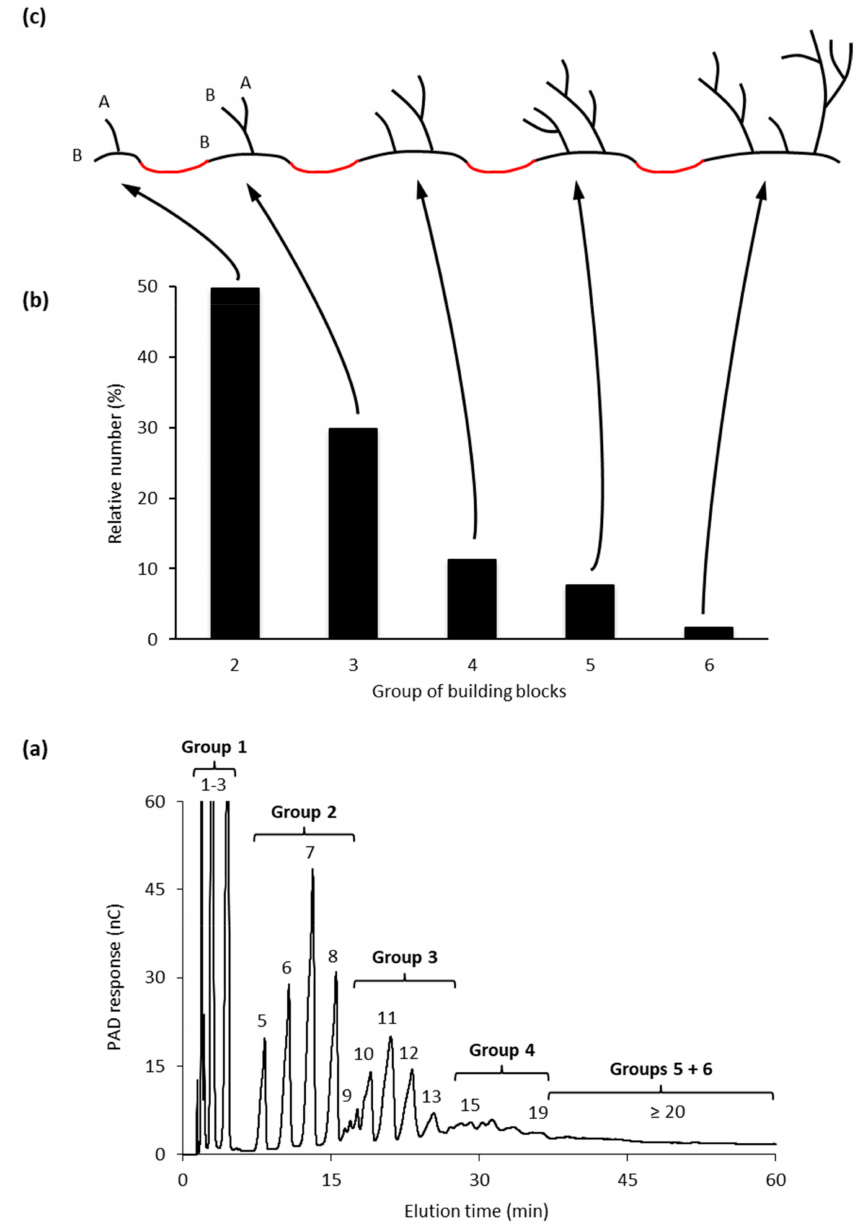
Figure 2. Composition of building block units in amylopectin. ( a ) The size distribution of building blocks from mung bean cotyledon amylopectin was determined by HPAEC-PAD and obtained by α -amylolysis and successive β -amylolysis. Groups of building blocks and DP of the peaks are indicated. Group 1 contains Glc, maltose and maltotriose, Groups 2–6 are branched dextrins, of which individual peaks of Groups 5 and 6 are not resolved by HPAEC. ( b ) The relative number of branched building blocks of the respective groups. The PAD response was calibrated to quantitative amounts for each DP. ( c ) The principal structures of the branched building blocks with A- or B-chains indicated for groups 2 and 3. Group 5 contains building blocks with 5–7 chains and group 6 has ≥ 8 chains. The multitude of possible structures of building blocks increases rapidly with the number of chains. Red lines between the building blocks symbolize the inter-block